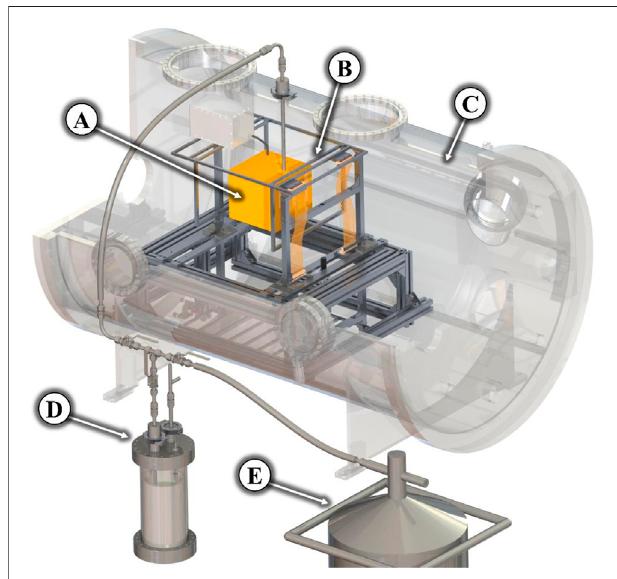
FIGURE 2 | Measurement setup with the cryo-box (A) on the thrust balance (B) inside the vacuum chamber (C) connected to a liquid nitrogen evaporator (D) and supplied by a dewar (E)